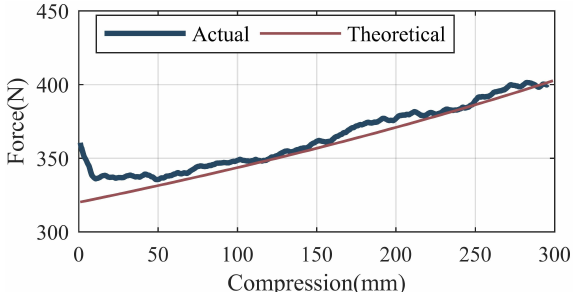
Figure 7. Result of the stiffness identification of the gas